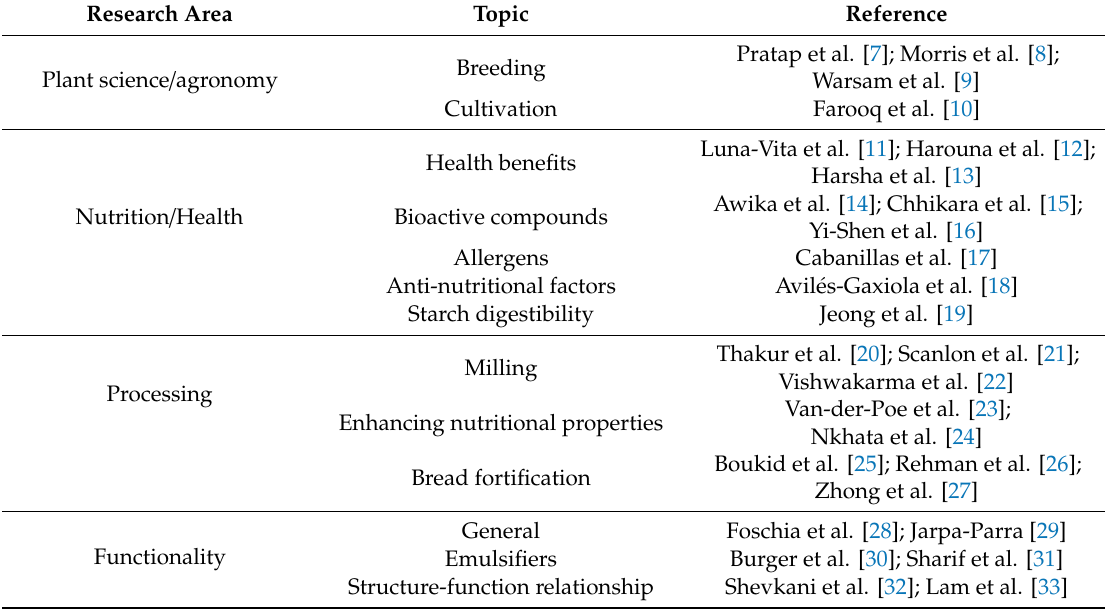
Table 1. Topics of the main reviews published on pulses (source: Food Science and Technology Abstracts; 2018–2019; updated to 03 July